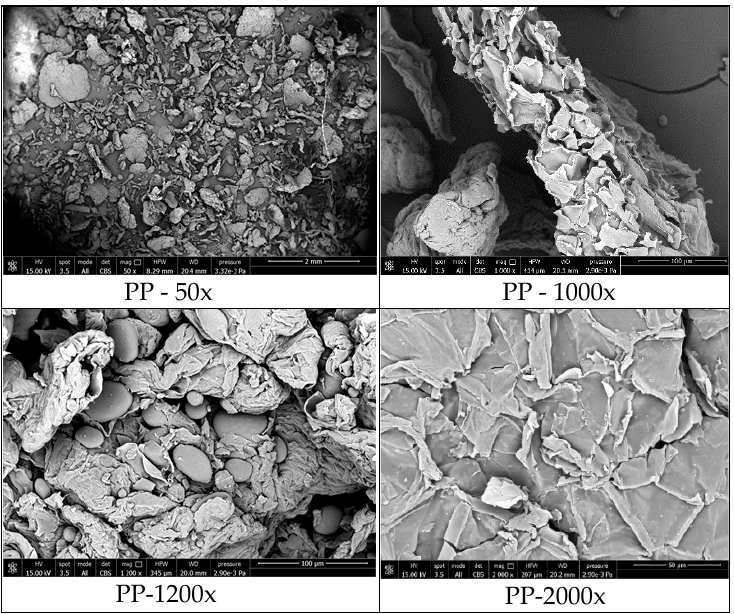
Figure 2. SEM images of the PP powder at the magnifications indicated.